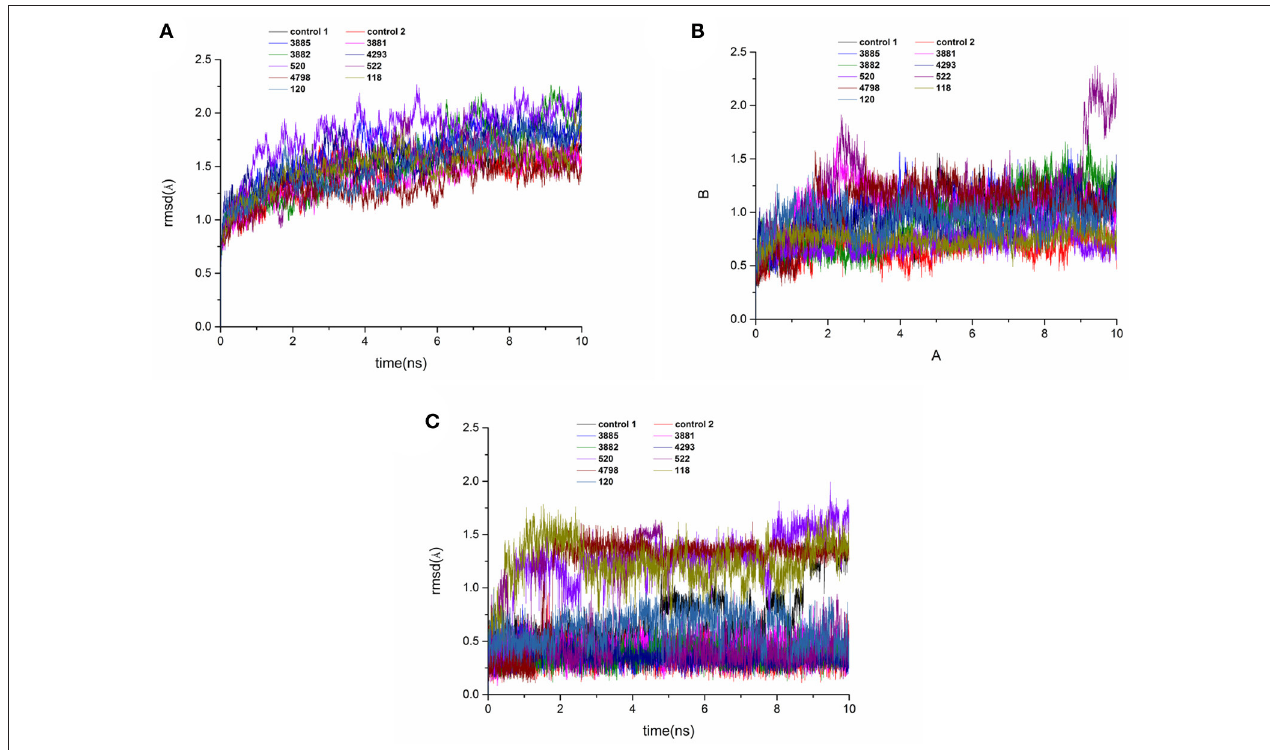
FIGURE 11 | RMSD of the backbone C α atoms (A), protein active pocket with residues of 5 Å around ligand (B) and heavy atoms of ligand (C) of the HPPD complexes with reference to the first snapshots as a function of time.